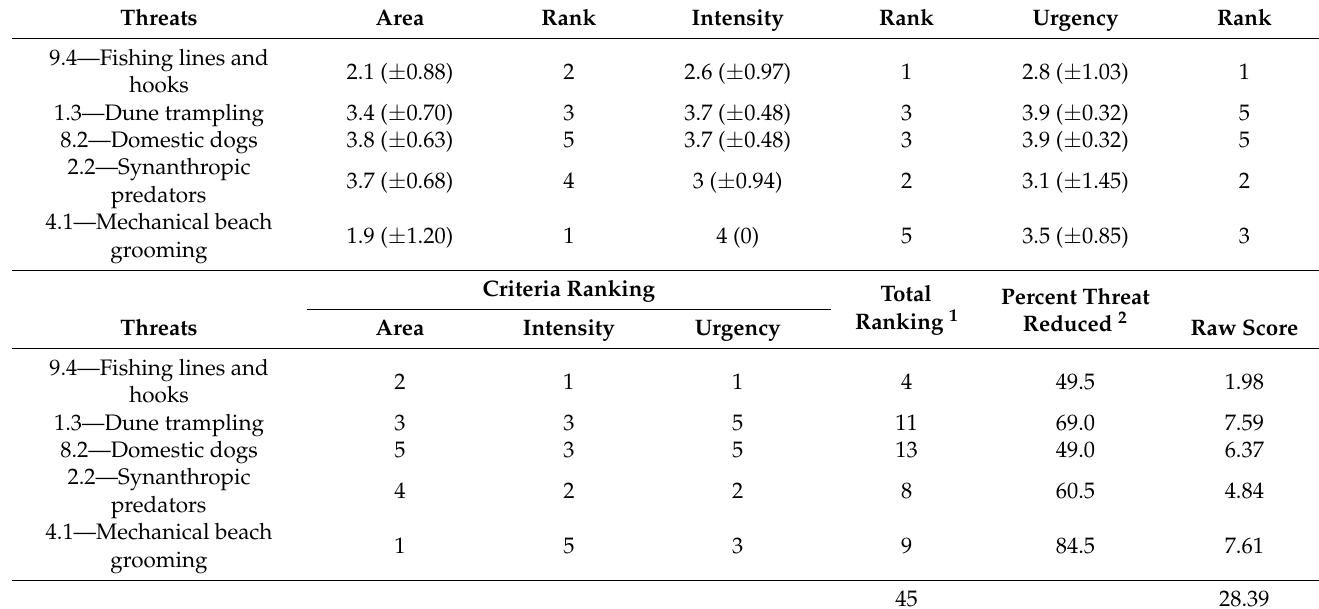
Table 2. Threat Reduction Assessment (TRA) procedure. Regime attributes of area, intensity, and urgency, and related ranks for the SPA ‘Torre Flavia’ Special Protection Area. Threat Reduction Assessment and procedure to calculate the TRA-I index. (1): Sum of ranking of area, intensity, and urgency. (2): Estimated percentage of threat mitigation over assessment period. TRA-I index = Σ (raw score/total ranking) × 100 =